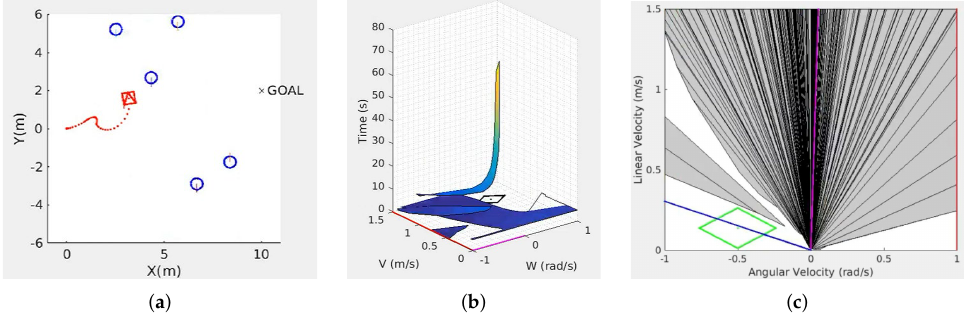
Figure 1. ( a ) Workspace with one robot (red) and several moving obstacles (blue); ( b ) velocity–time space DOVTS and velocity–time obstacle DOVT for two moving obstacles close to the robot and the corresponding projection on plane ( ω , v ) , which is the dynamic obstacle velocity DOVS; ( c ) DOVS, in which the dark areas represent unsafe velocities, and white areas represent velocities that can be selected for safe navigation.